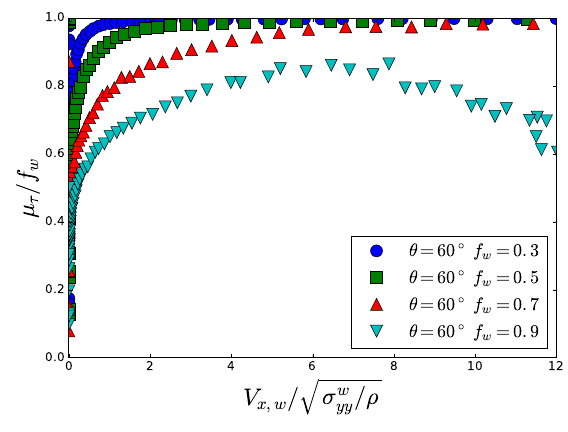
Figure 5. Zhu’s relation (ratio of the e ff ective friction coe ffi cient at sidewalls to the microscopic grain-sidewall friction coe ffi cient versus the Froude number at sidewalls V x ,w / depend on the grain-sidewall microscopic friction coe ffi